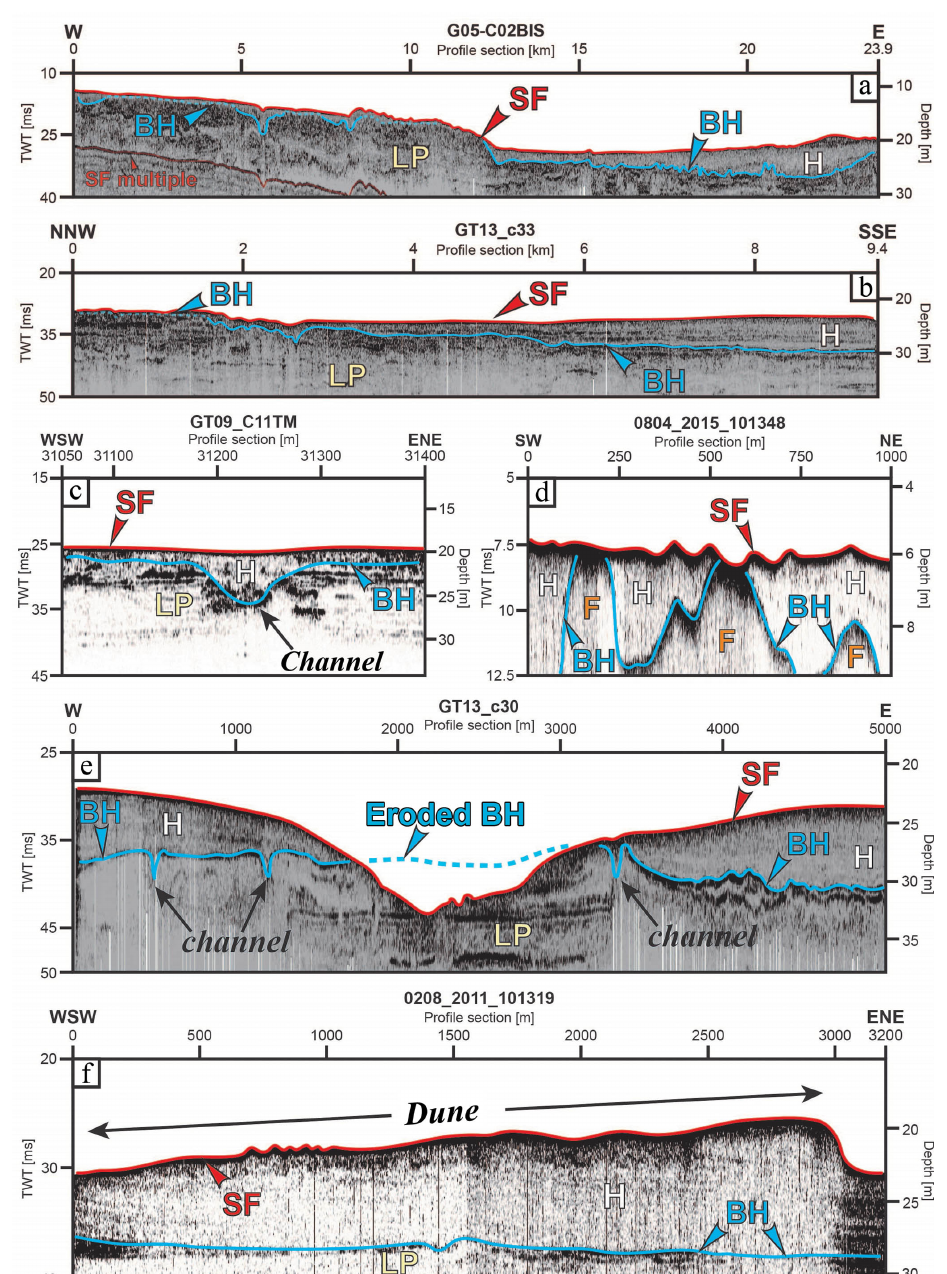
Figure 8. Examples of sub-bottom and Chirp sonar profiles (for explanation of the symbols, refer to the caption of Fig. 3); (a–b) regional Chirp profiles show that the Late Pleistocene paleotopography forms a basin in the eastern part which serves as a depocentre for the Holocene marine sediment (dashed blue line – base of the Holocene sediment where the sedimentary sequence is very thin or even absent or eroded); (a) a W–E oriented profile showing a difference in marine Holocene thickness in the western and eastern parts of the gulf. Note that thicker Holocene marine sequences in the western part of the gulf are filling channel-like features; (b) a NNW–SSE oriented profile showing the same difference in Holocene marine thickness; (c–f) variations of the thickness of marine Holocene sediment; (c) a profile from the central part of the gulf, where a thin Holocene marine sediment cover is characteristic, except where it fills pre-existing channels; (d) variation of Holocene sediment thickness controlled by the pre-existing Flysch paleotopography in the area of Debeli rtiˇc; (e) Holocene sediment erosion in the seafloor depression in front of Piran (Fig. 6); note also Holocene filling of pre-existing channels; (f) thicker Holocene sedimentary sequences visible on a profile crossing the area of dunes in front of Piran (Fig. 6). For locations of the profiles, see Fig. 5.